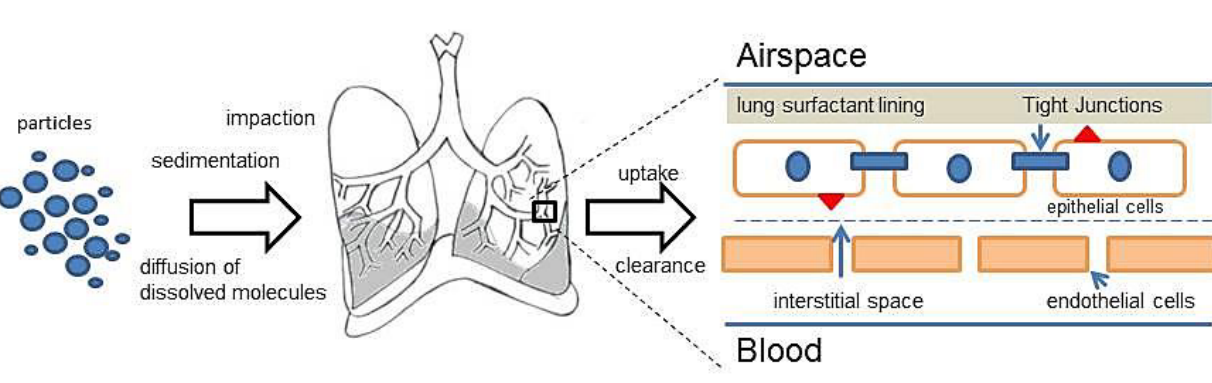
Figure 2. The deposition mechanism and uptake of particles in the lungs along with different cell